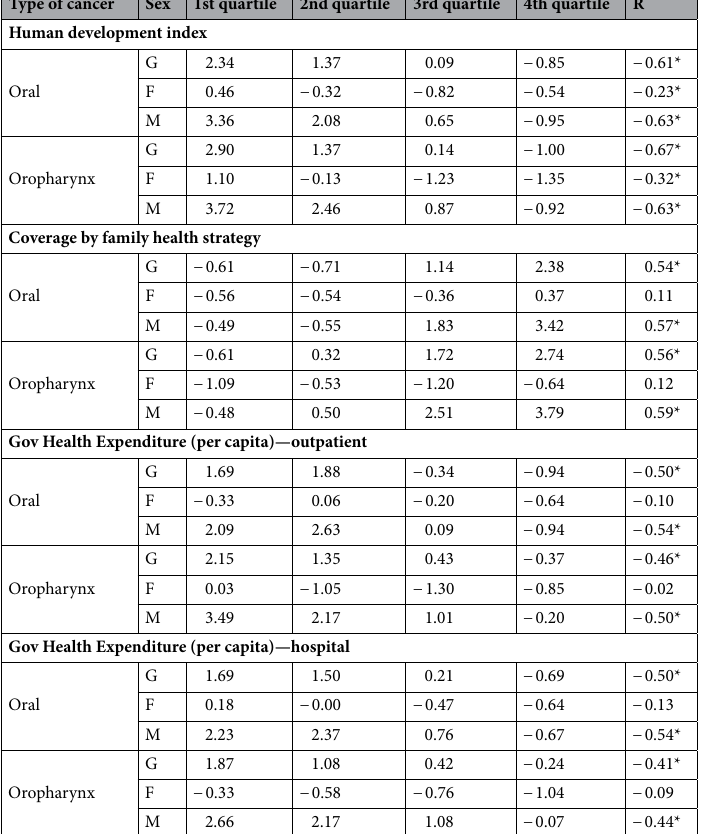
Table 2. Trends of oral and oropharyngeal cancer mortality: annual percent change median, by sex, and quartiles of the Human Development Index, coverage by Family Health Strategy, and government